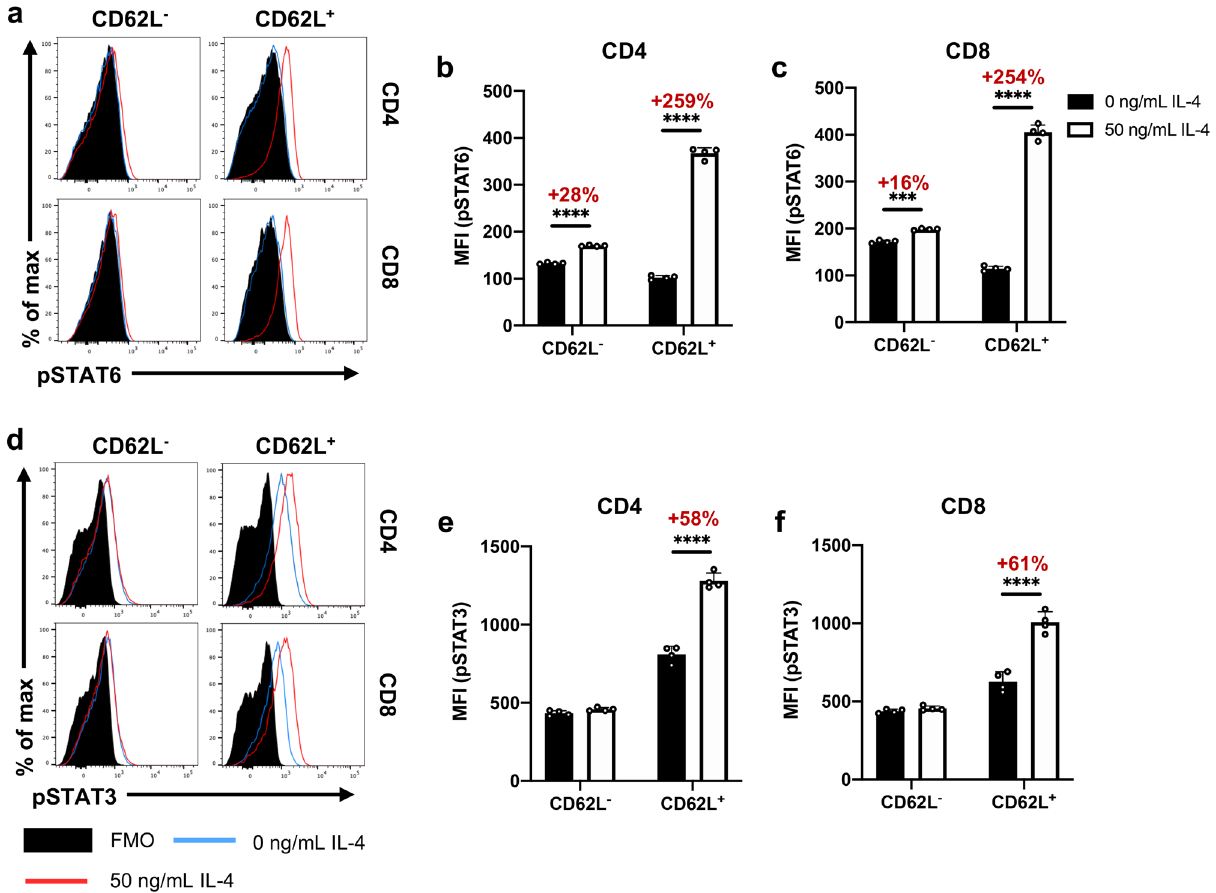
Figure 4. IL-4-induced activation of STAT6 and STAT3 contingent on T cell CD62L status. (a) Whole spleen homogenate derived from naïve 6–8-week-old female BALB/c mice were stimulated with 50 ng/mL IL-4 in vitro for 24 h prior to flow cytometric analysis. Representative histograms showing pSTAT6 expression among pre-gated CD4 and CD8 T cells partitioned based on CD62L status. MFI (pSTAT6) of both (b) CD4 and (c) CD8 T cells. Similarly, the expression of pSTAT3 among T cell subsets with respect to CD62L was evaluated (d–f) . Data are represented as mean + SD, where dots represent biological replicates from a single